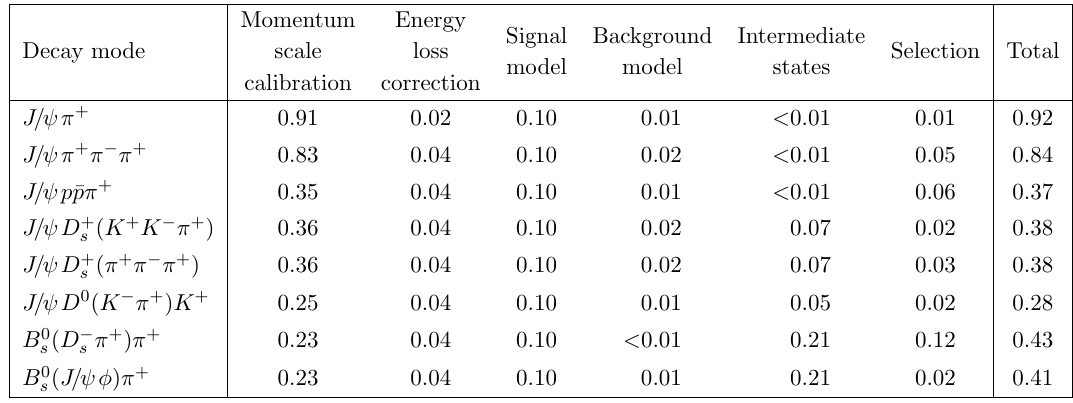
Table 3. Summary of systematic uncertainties (in MeV =c 2 ) on the B +